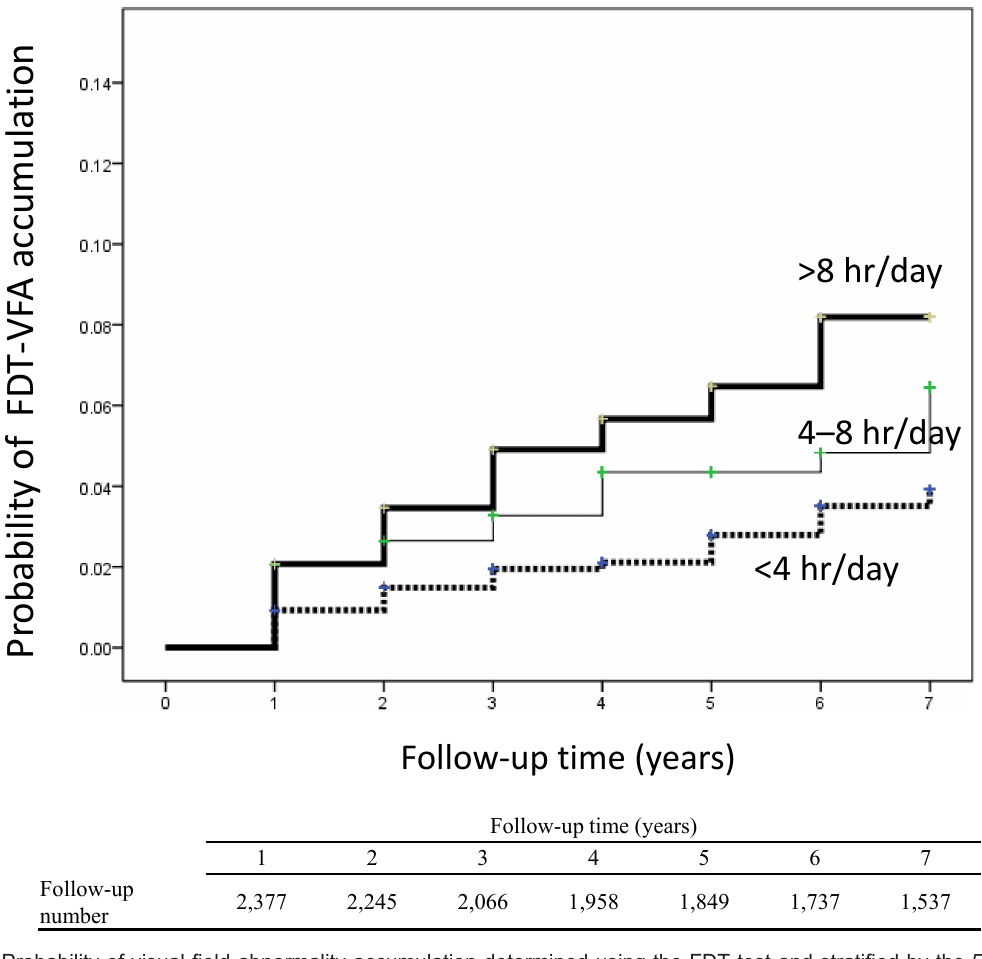
Figure 1. Probability of visual fi eld abnormality accumulation determined using the FDT test and strati fi ed by the 5-year mean time spent at a computer. The probability of visual fi eld abnormality accumulation, determined using the FDT test, was calculated using the Kaplan-Meier method. Bold, solid, and broken lines indicate 5-year mean times spent at a computer of > 8hr / day, 4 – 8hr / day, and < 4hr / day, respectively. FDT, frequency doubling technology